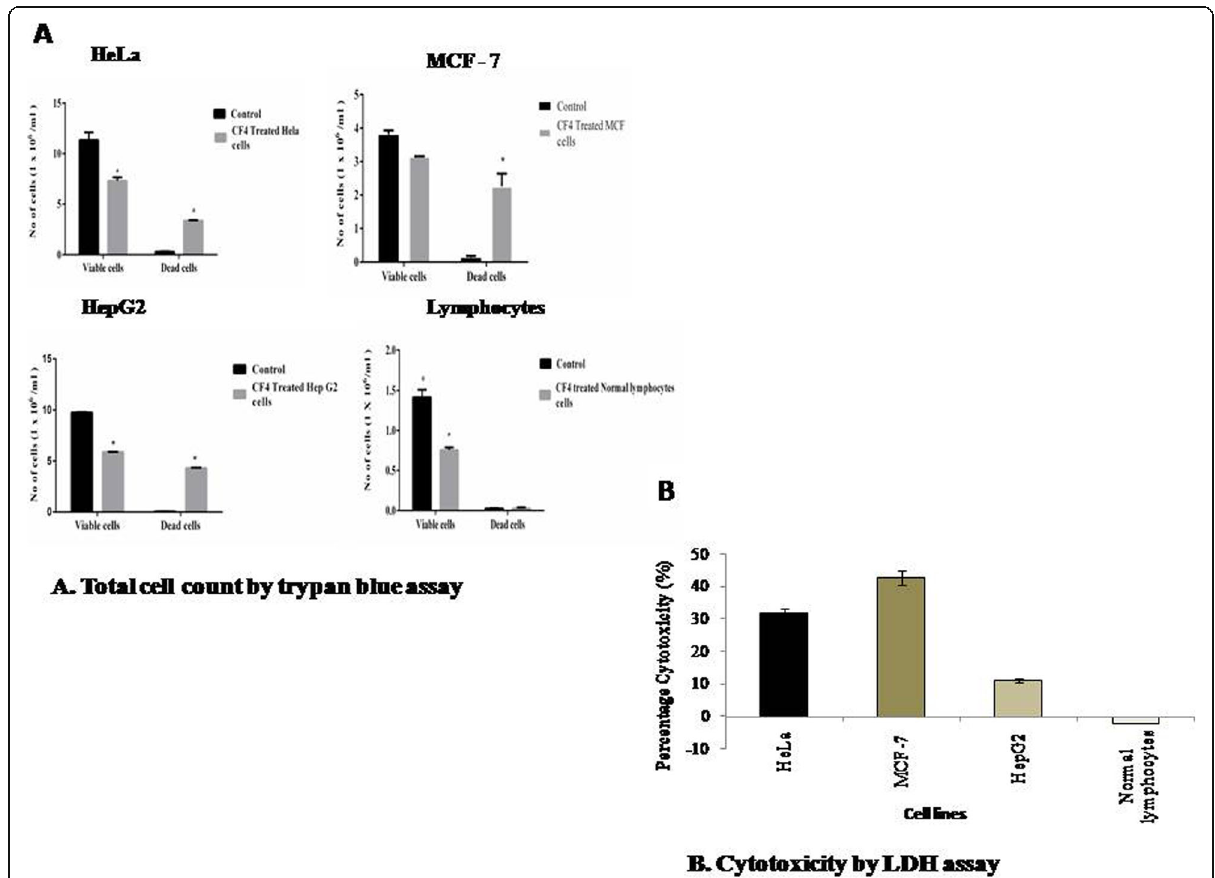
Fig. 5 In vitro cytotoxicity assays. a Cell count of HeLa, MCF-7, HepG2 and lymphocyte cells as per trypan blue assay. b Effect of CF4 fraction on LDH activity of different cell lines. The values are expressed as mean ± SE. An asterisk denotes significance at p < 0.05 and two asterisks denotes significance at p < 0.01